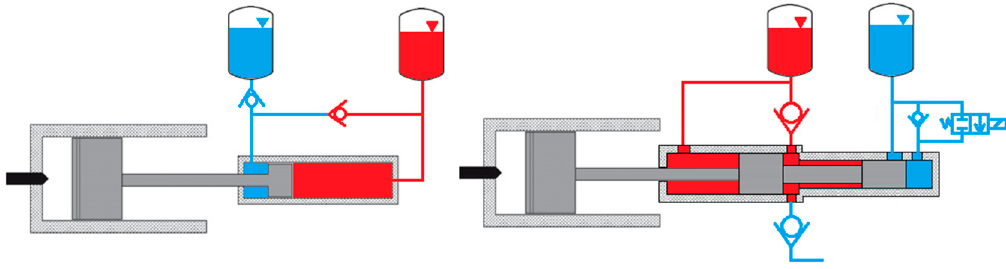
Figure 11. One kind of single-piston HFPE [27].